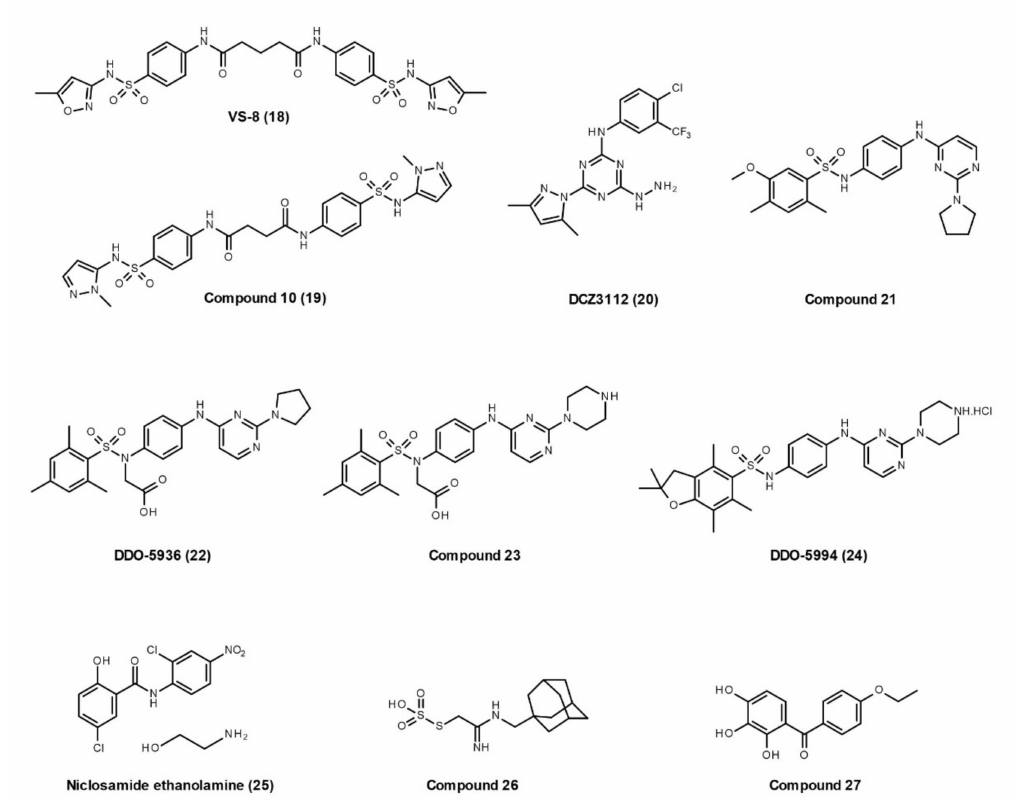
Figure 5. Developed small molecules with the ability to disrupt Hsp90–Cdc37